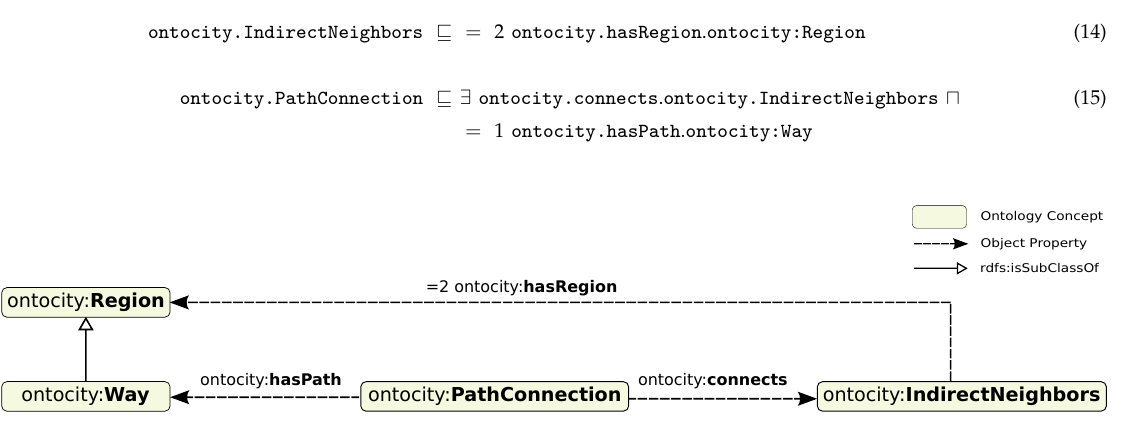
Figure 3. The PathConnection Pattern in OntoCity representing a symmetric n-ary